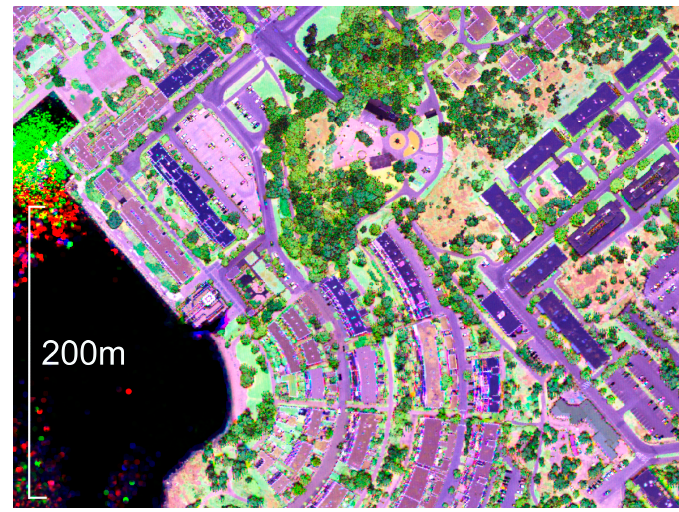
Figure 2. Example raw data of multispectral ALS for built areas. (The plot is in from WGS84 coordinates 60°09 ′ 03 ″ N, 24°38 ′ 08 ″ E).